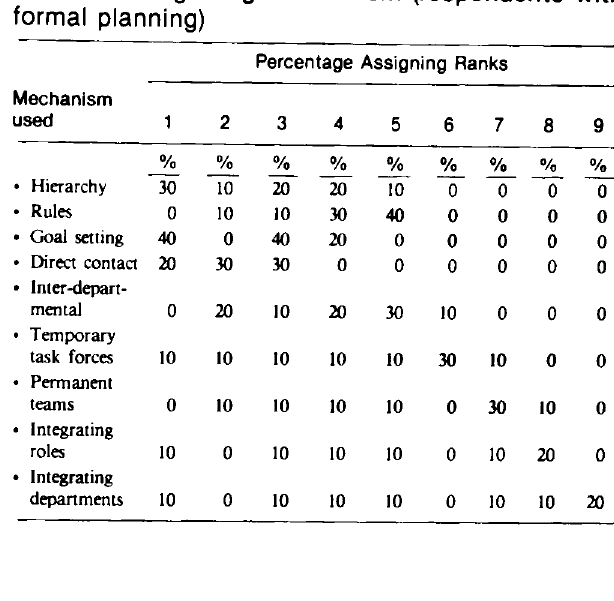
Table 9b Integrating mechanism (respondents